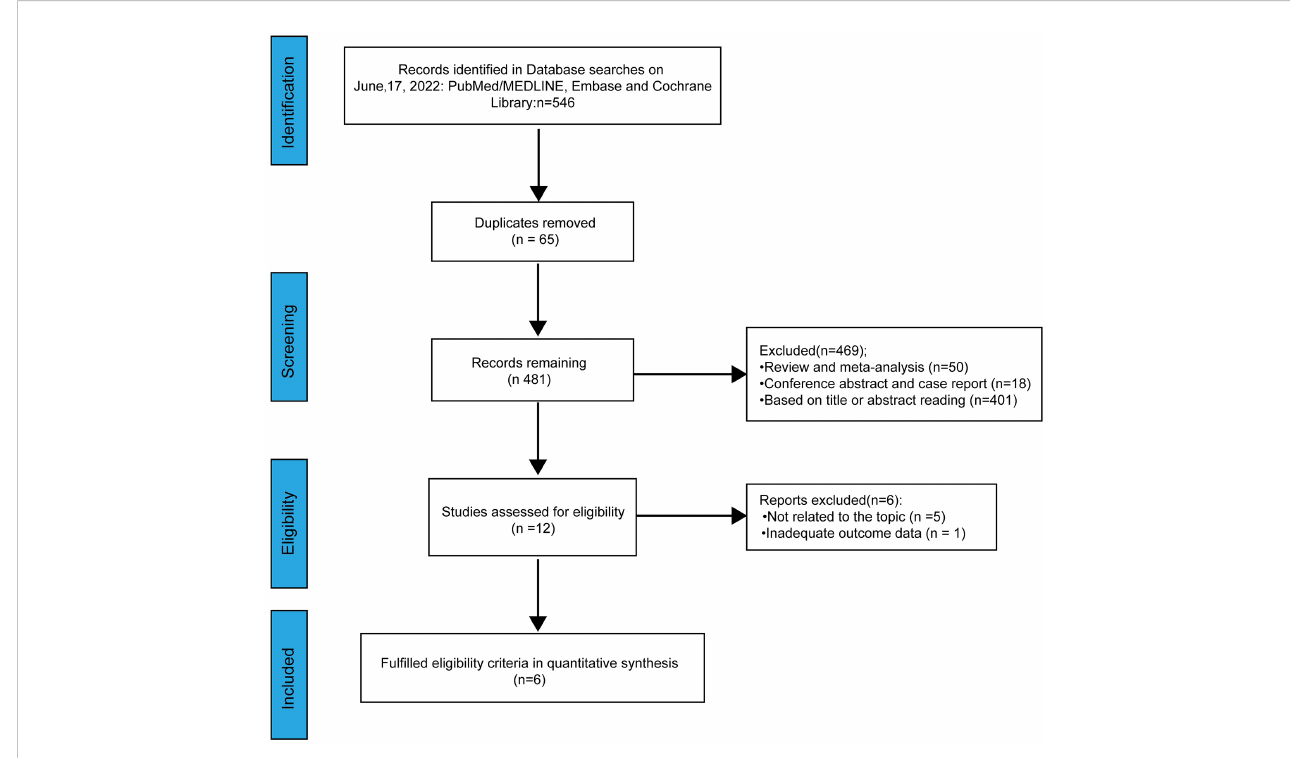
FIGURE 1 PRISMA fl ow diagram of the process for the identi fi cation of eligible